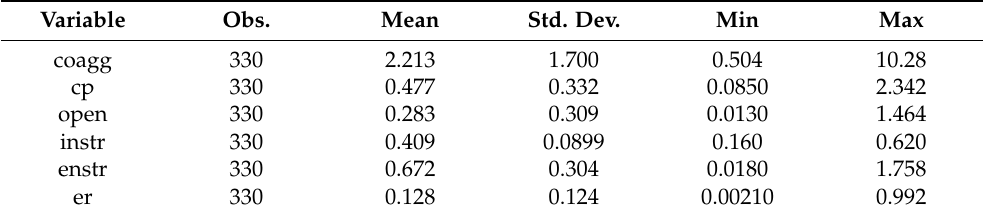
Table 1. Descriptive statistics.